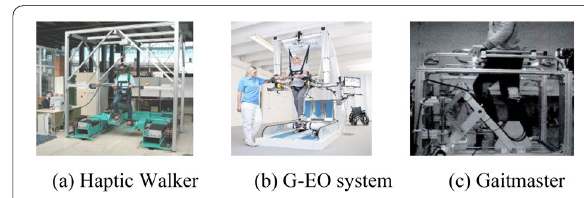
Figure 2 Pedal-type gait balance training robot